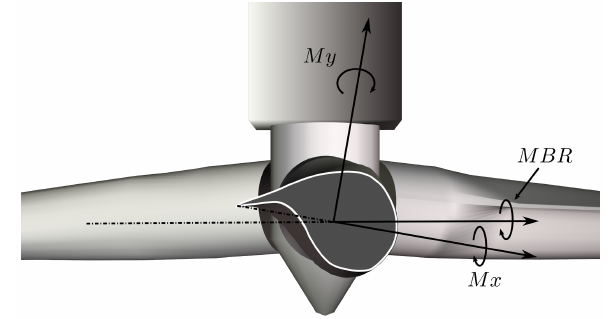
Figure 4. Orientation of the blade-root flap-wise, M x , and edge- wise, M y , bending-moment sensors. These sensors pitch with the blade. MBR is the no-pitch rotor-plane projection of the blade-root bending